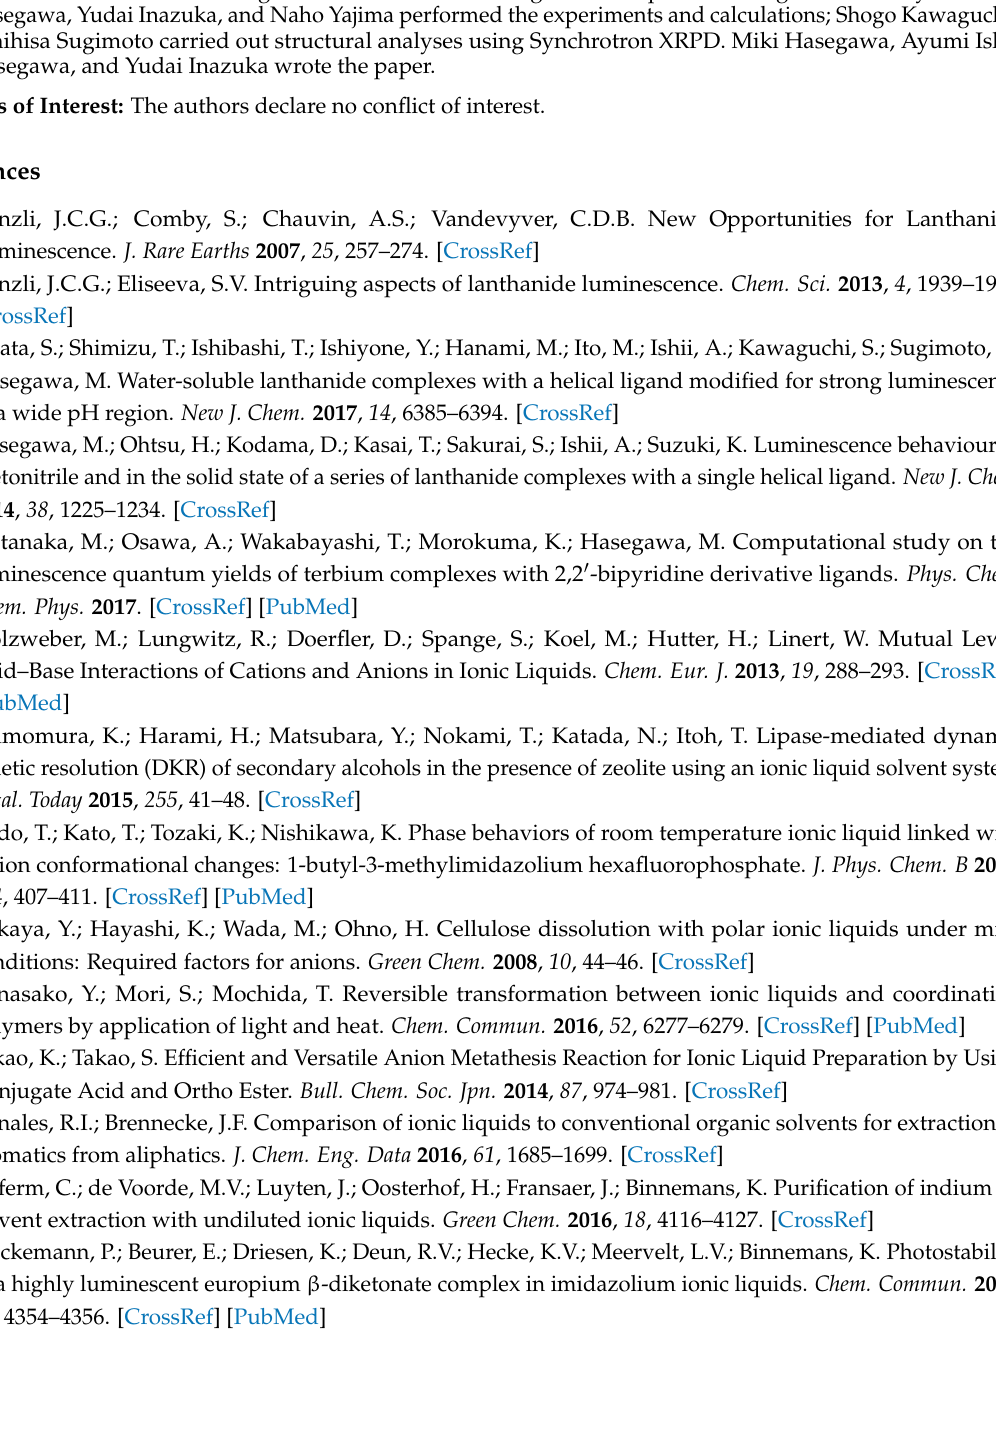
Supplementary Materials: The following are available online. Figure S1: Luminescence decay curves of EuL in [BMIM][PF 6 ] and acetonitrile; Figure S2: Excitation spectra of EuL in [BMIM][PF 6 ] and in acetonitrile; Figure S3: Electronic absorption, emission spectra, and decay curves of EuL in [BMIM][PF 6 ]/acetonitrile; Figure S4: Projection views of a [EMIM][PF 6 ] single